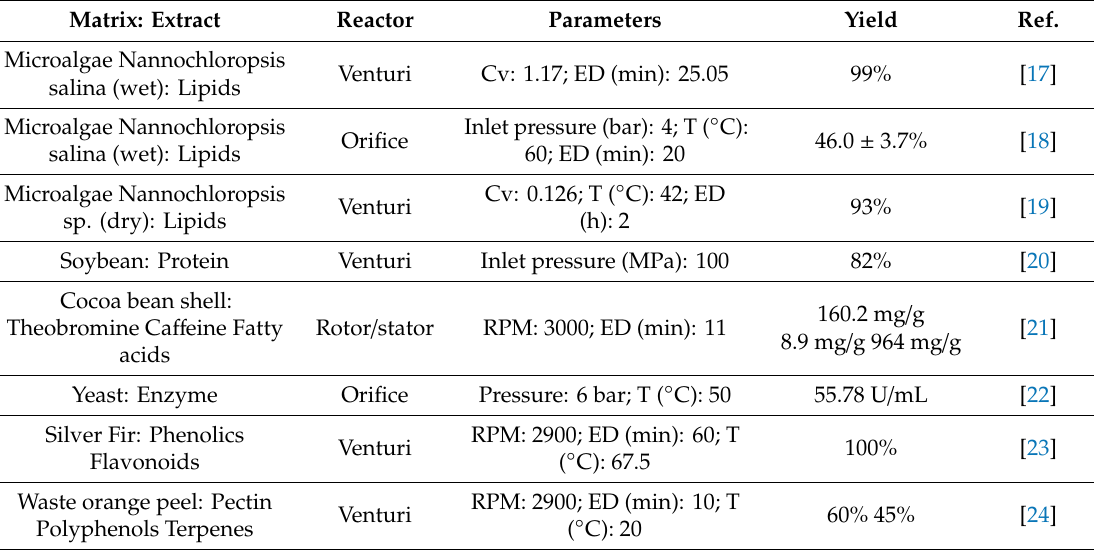
Table 2. Vital products extracted by HC-assisted